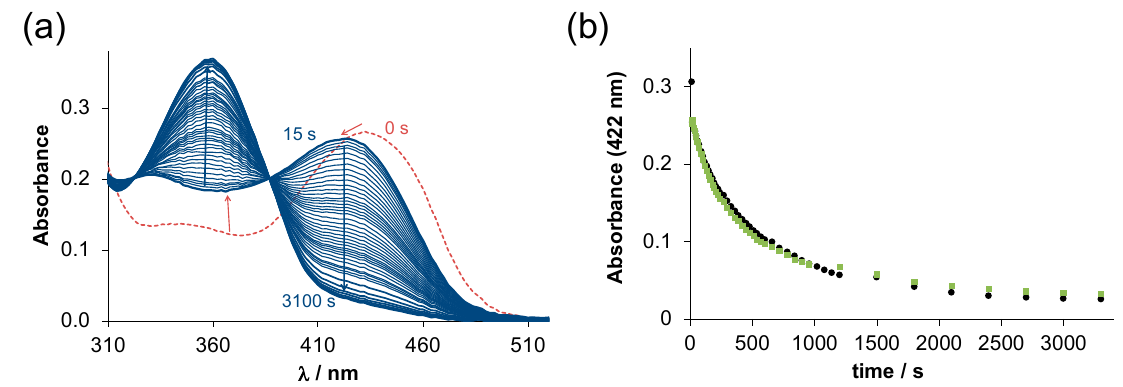
Figure 9. ( a ) Time-dependent changes of the UV–vis absorption spectra of the copper(II) ‒ Triapine ‒ HSA (1:1:1) system in the presence of 50 equiv. GSH at pH 7.4 in pure water under argon atmosphere. ( b ) Absorbance changes at 422 nm recorded for the binary copper(II) ‒ Triapine ( ● ) and for the ternary copper(II) ‒ Triapine ‒ HSA ( ■ ) systems. { c Cu(II) = c Triapine = c HSA = 25 μM, c GSH = 1250 μM; pH = 7.4 (20 mM HEPES); T = 25 °C; I = 0.10 M (KCl); ℓ = 1 cm}.